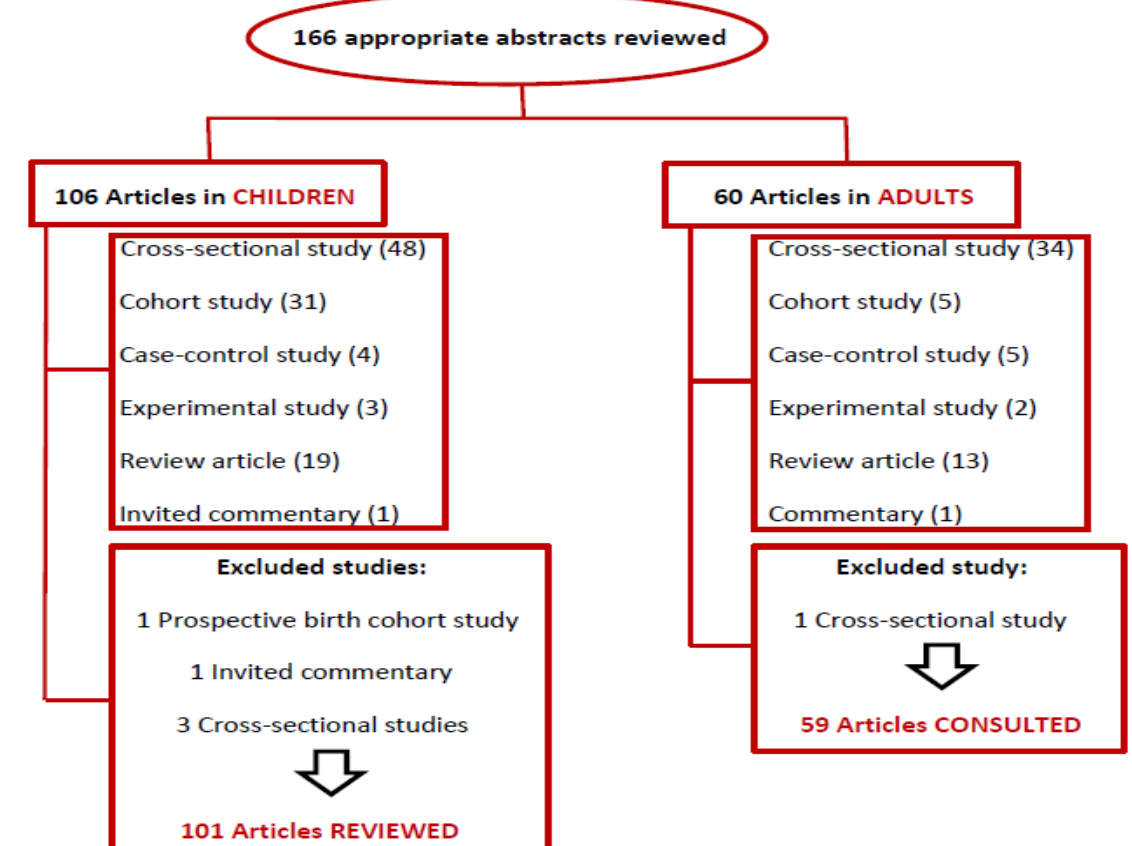
Figure 1. Number of all abstracts consulted, in both adults and children, with the number of excluded and included articles in this review